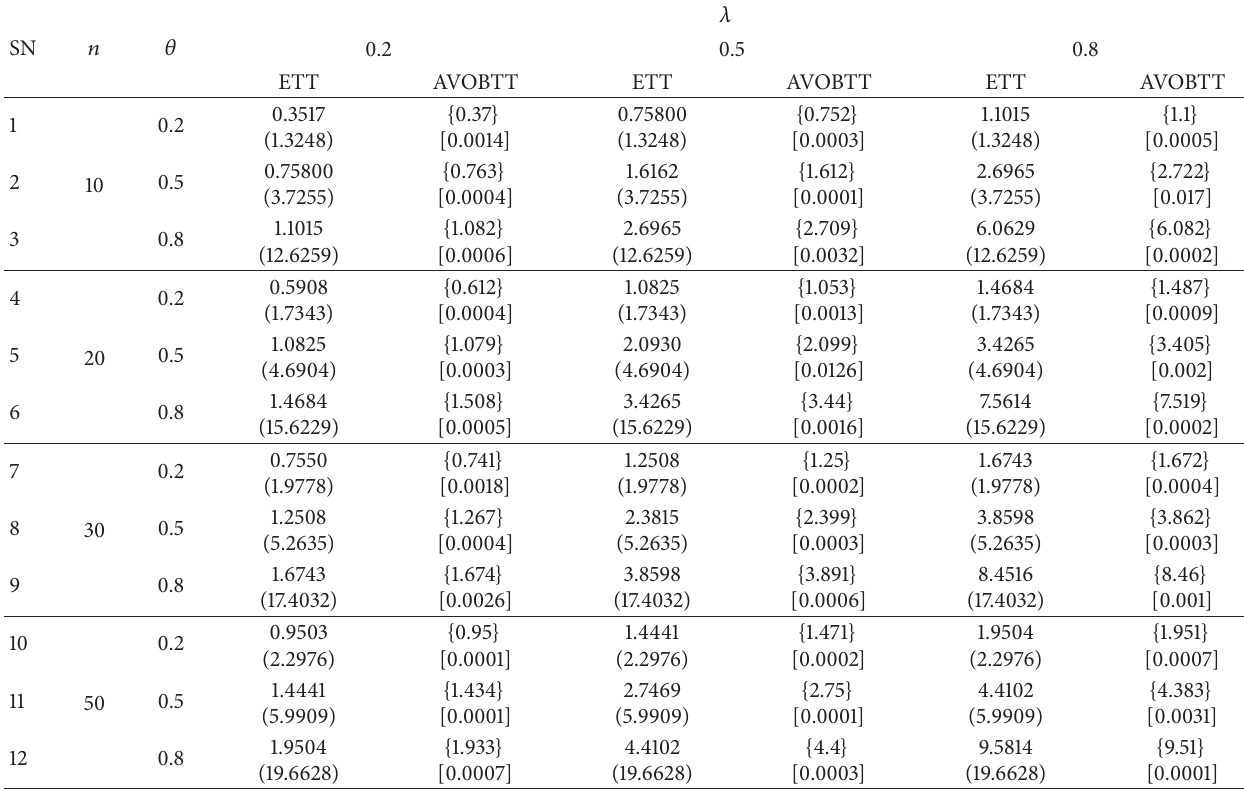
Table 2: Expected time on test (ETT) and its